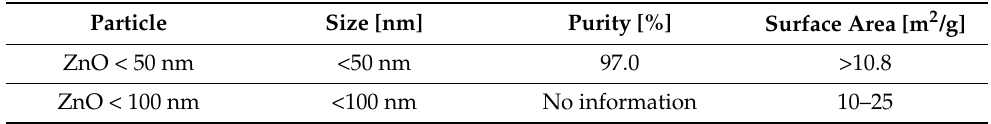
Table 1. Characteristics of ZnO NPs used for the